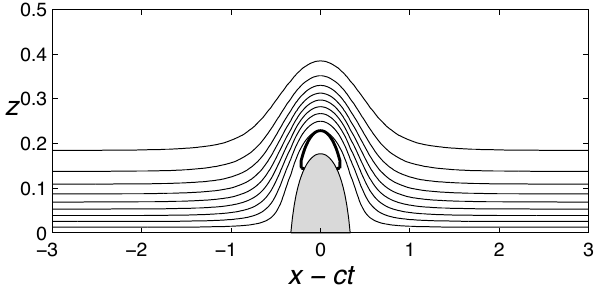
Fig. 7. Stagnant-core DJL solution for λ = 8, s c =1, and c =0.4. The core is indicated by the shading and the thin lines are s contours in increments of 0 . 1. The area inside the heavy line and above the core has Ri ≤ 0.25. Note that only the lower half of the water column is shown.